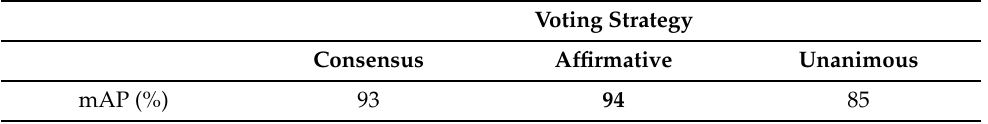
Table 4. mAP scores of the ensemble model on the Klim dataset using three different methods for constructing ensemble outcome.